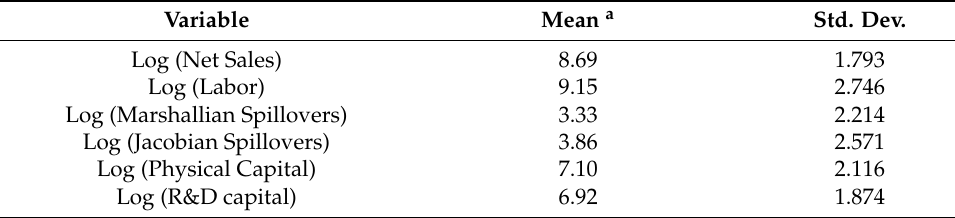
Table 2. Data statistics.